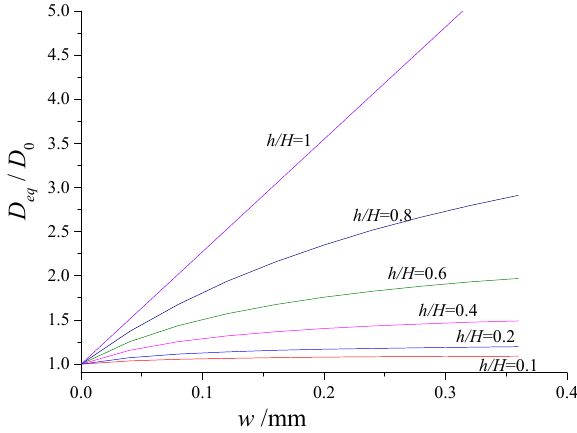
/ D / H and w obtained from Equation 0 as a function of h